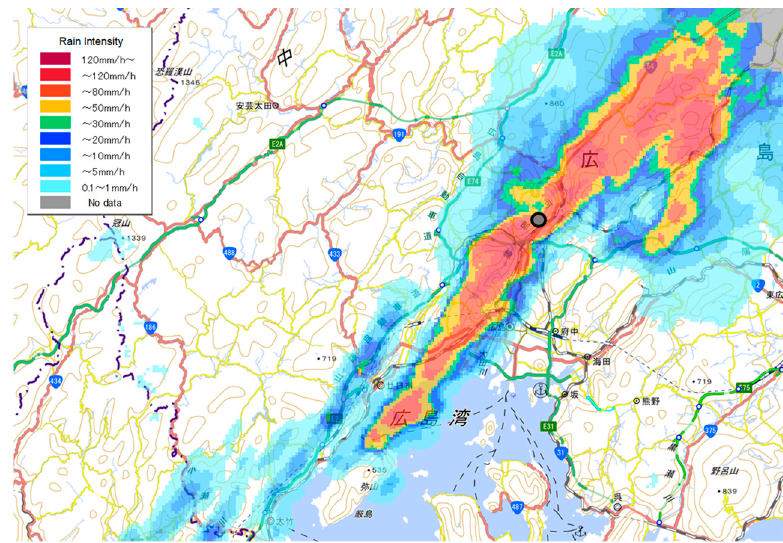
Figure 5. Horizontal distribution of rain intensity at 03:00 on August 20, 2014 (Source: Japanese Ministry of Land, Infrastructure, Transport and Tourism). The black circle indicates the location of Asaminami, Hiroshima.